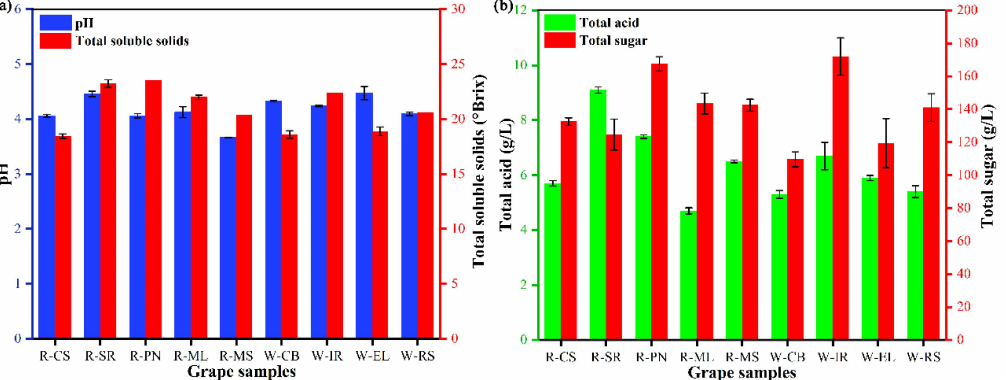
Figure 1. Overall differences in pH, soluble solids content ( a ), total sugars, and total acidity ( b ) of different wine grapes.